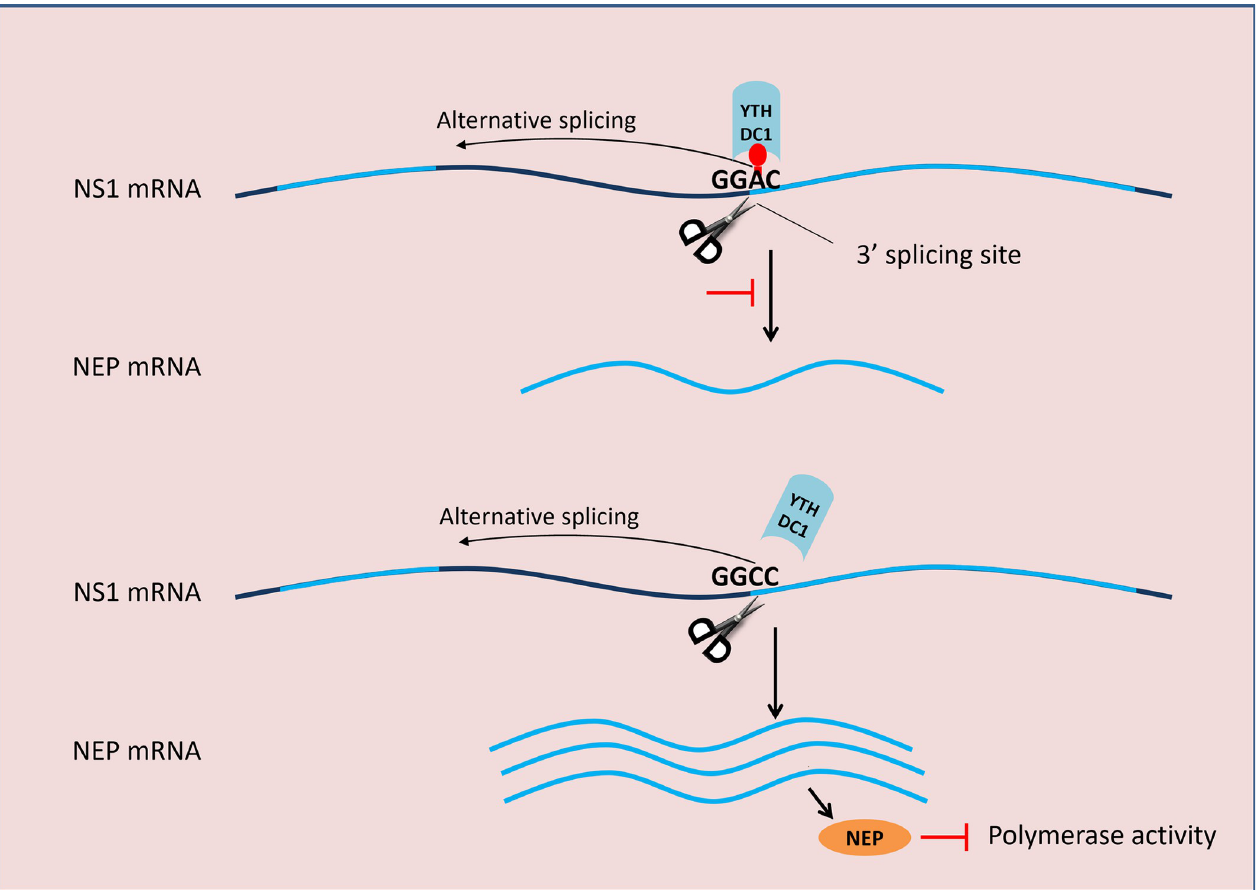
Fig 7. Working model for the regulation of NS mRNA splicing. NEP mRNA is a spliced form of NS1 mRNA. The splicing complex binds (scissors) to the 3’ splicing site of NS1 mRNA and regulates alternative splicing. YTHDC1 binds to the m 6 A modification site on the 3’ splice site and inhibits the splicing process. The A530C mutation results in reduced binding of NS mRNA by YTHDC1, which promotes NS1 mRNA splicing and produces more NEP, thereby inhibiting viral polymerase activity.